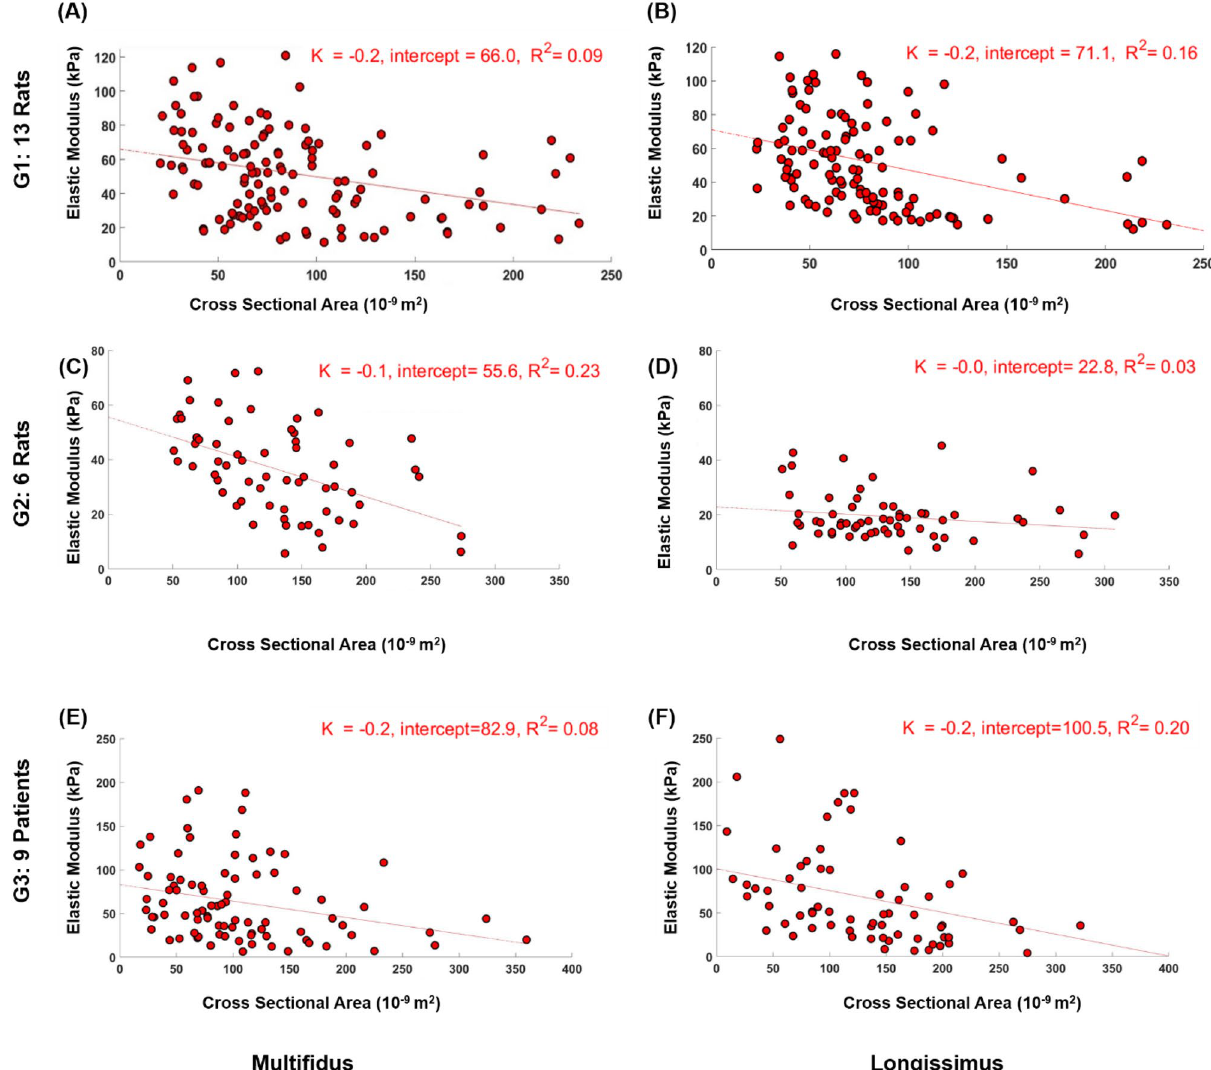
Figure 3. Correlation between cross sectional area and elastic modulus of fiber bundles from multifidus and longissimus of G1 ( A , B ), G2 ( C , D ), and G3 ( E , F ). All P < 0.02 except for G2 longissimus bundles that P = 0.16 ( D